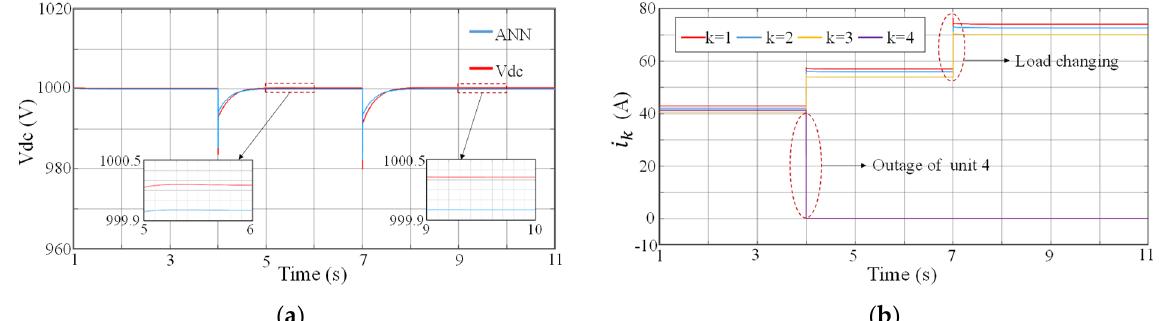
Figure 8. ( a ) Values of DC bus voltage and ANN output in case study 4; ( b ) Values of currents of the bidirectional DC ‐ DC converters in case study 4.